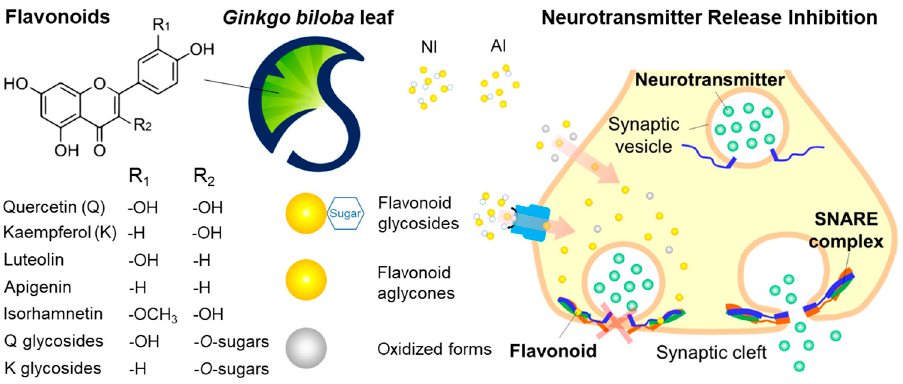
Figure 6. Graphical representation of the proposed mechanism on the neurotransmission inhibitory activities of the non-hydrolyzed isolate (NI) and acidolyzed isolate (AI) of Ginkgo biloba leaf.